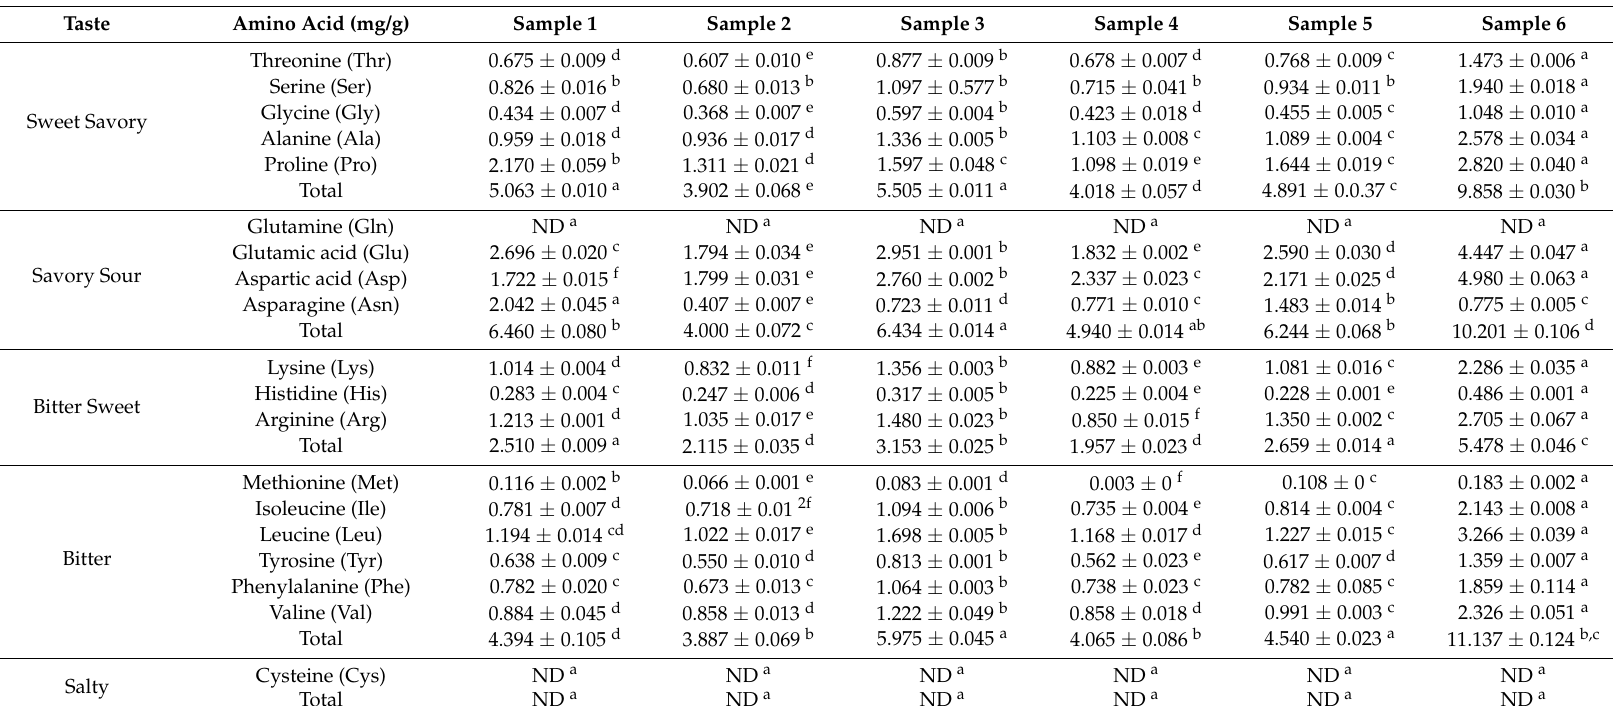
ND: not detected values with different superscript roman letters (a–f) in the same row are significantly different ( p <